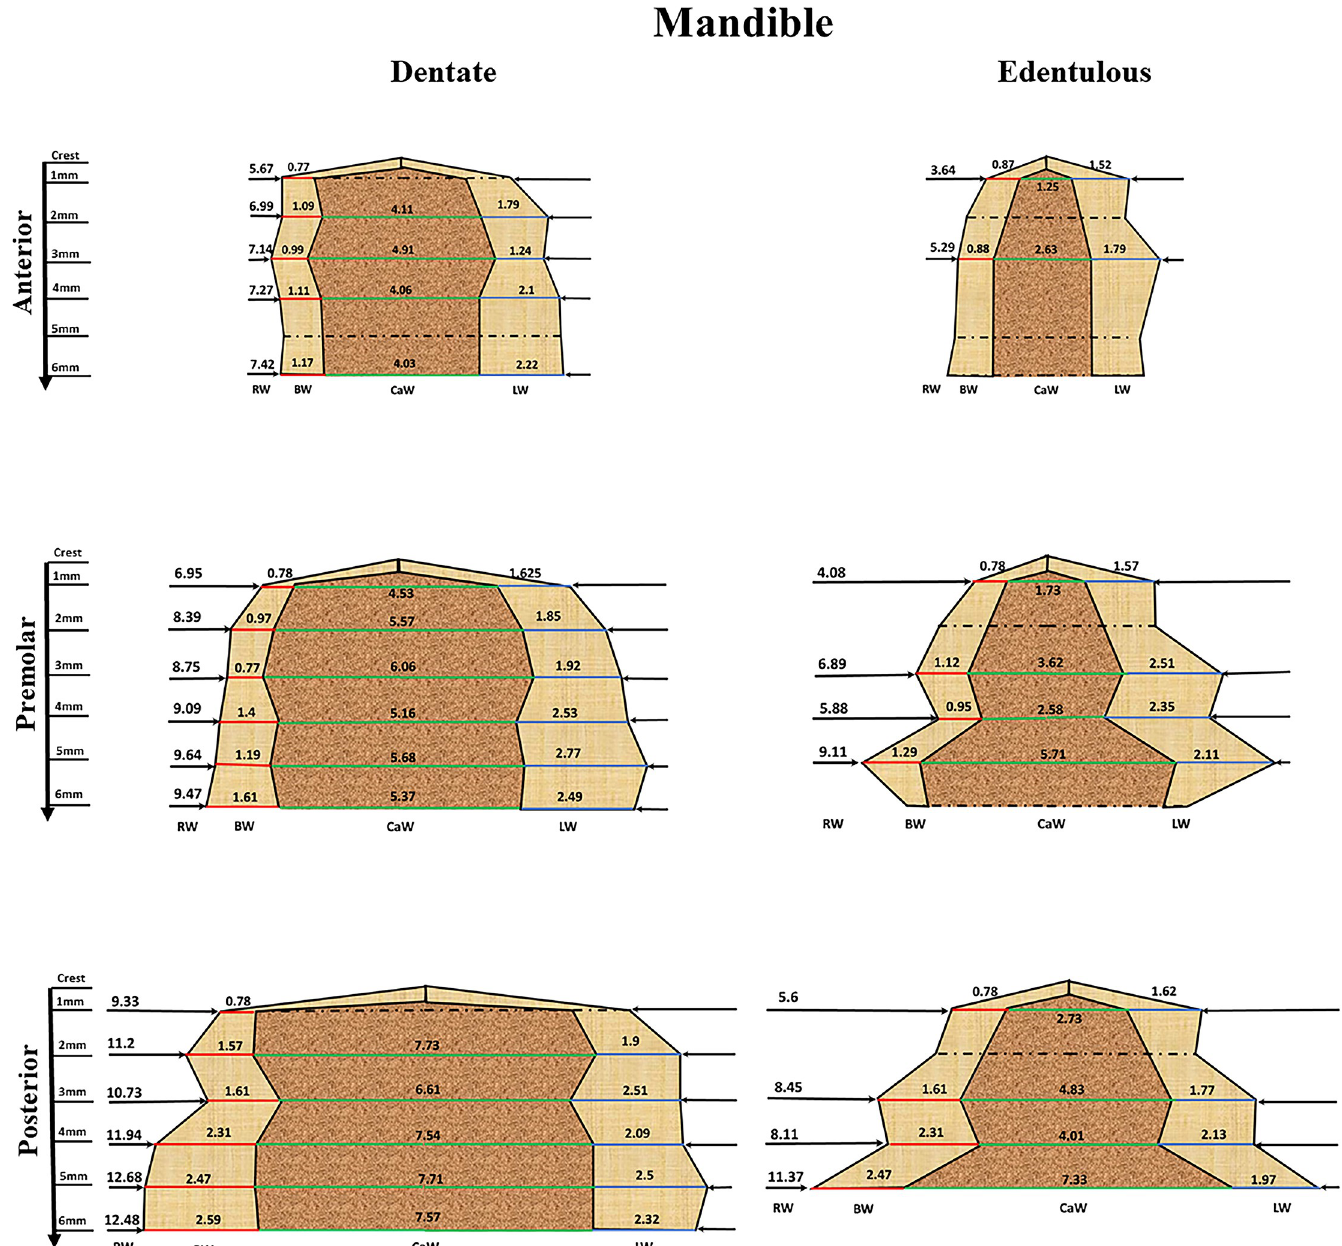
Fig 5. The mandible dentate and edentulous ridge. The fig was constructed by using the combined mean obtained from the meta-analysis results for the RW- black line, BW—red line and LW—blue line and the calculated CaW marked by green line. The interrupted lines represent an estimated